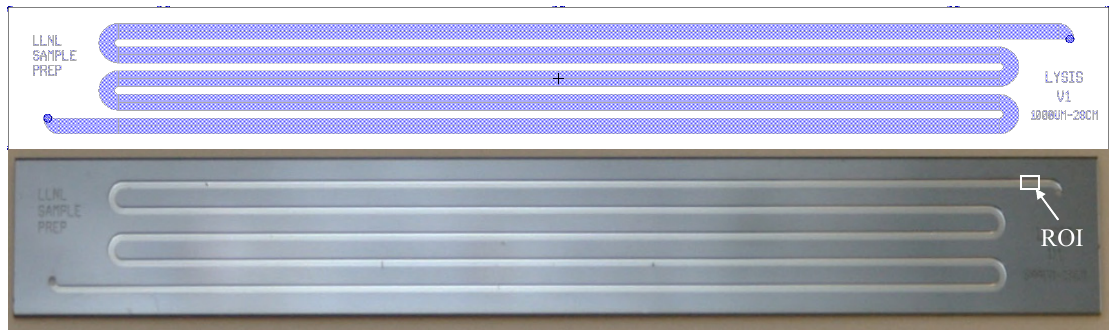
Figure 1. Silicon and glass microfluidic lysis chip—layout in Tanner L-edit software ( top ) and finished device ( bottom ). The top device has a 1 mm wide channel and the bottom device an 0.5 mm wide channel. The external chip dimensions are 70.5 mm × 9 mm × 1 mm. The rectangle marked “ROI” denotes the imaging area used for the BacLight LIVE : DEAD membrane permeabilization assay (see Section